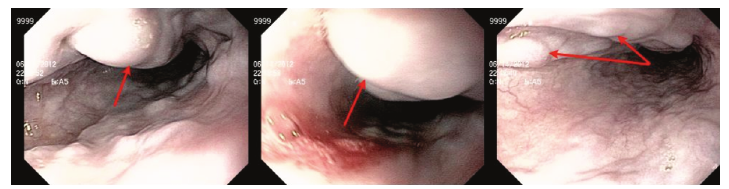
Figure 1: Esophagogastroduodenoscopy showing “downhill” varices in the upper 3rd of